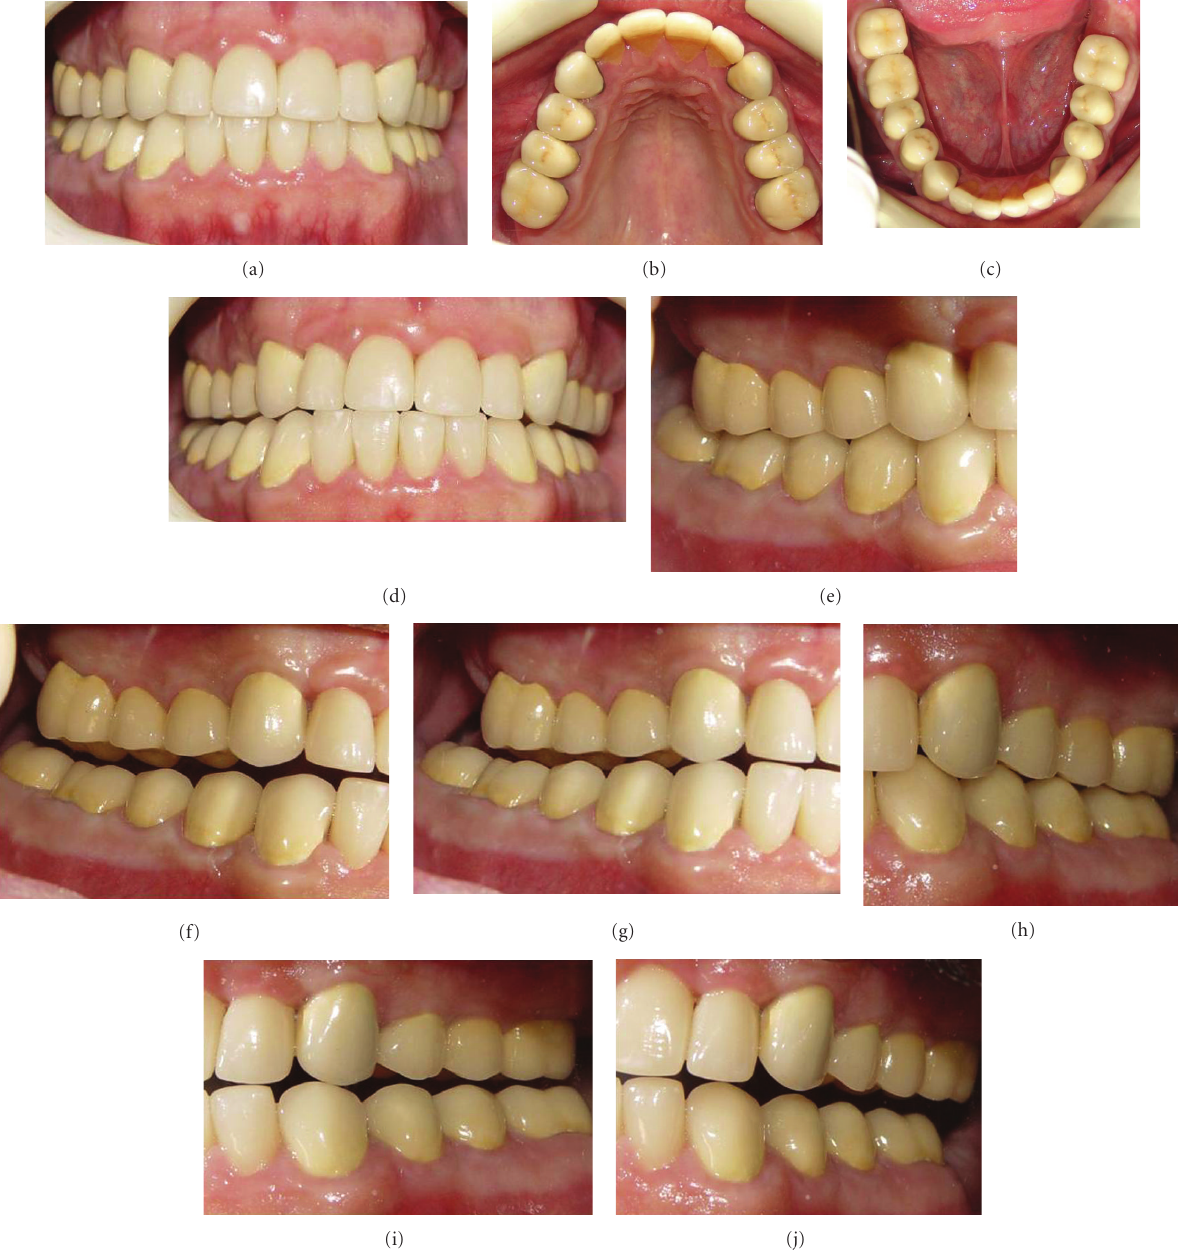
Figure 8: A 1-year posttreatment view of restoration: (a) frontal CR view; (b) maxillary occlusal view; (c) mandibular occlusal view; (d) frontal protrusive view; (e) right-side CR view; (f) right-side nonworking view; (g) right-side working view; (h) left-side CR view; (i) left-side working view; (j) left-side nonworking